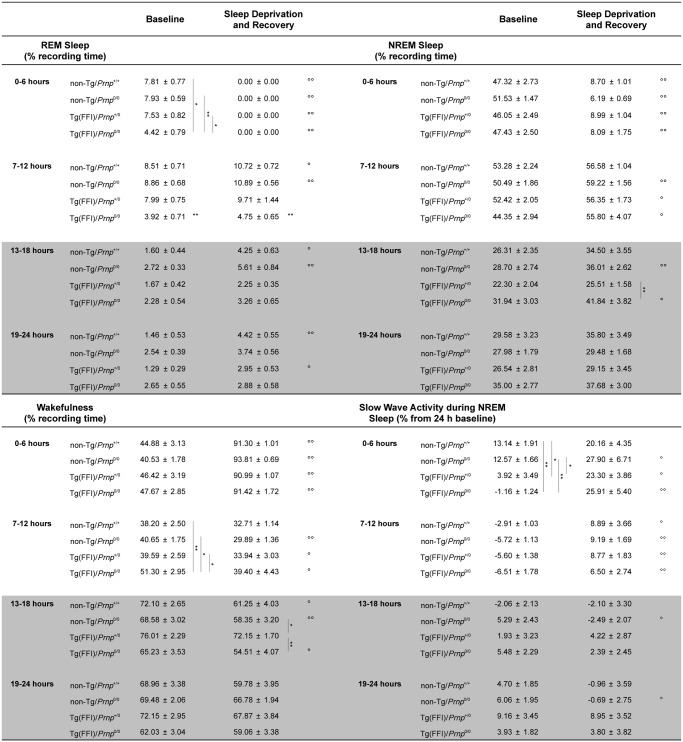
Amount of sleep and EEG delta power during NREM sleep.Values are the mean ± SEM of 8 non-Tg/Prnp
+/+, 10 non-Tg/Prnp
0/0, 8 Tg(FFI-26)/Prnp
+/0 and 9 Tg(FFI-26)/Prnp
0/0 mice. The grey areas indicate the dark portion of the light-dark cycle. *,°p ≤ 0.05; **,°°p ≤ 0.01. A mixed model for repeated measures was used. Between-strain comparisons (*) were done by one-way ANOVA with Bonferroni's correction. Within-condition comparisons (°) were done by paired Student's t test.